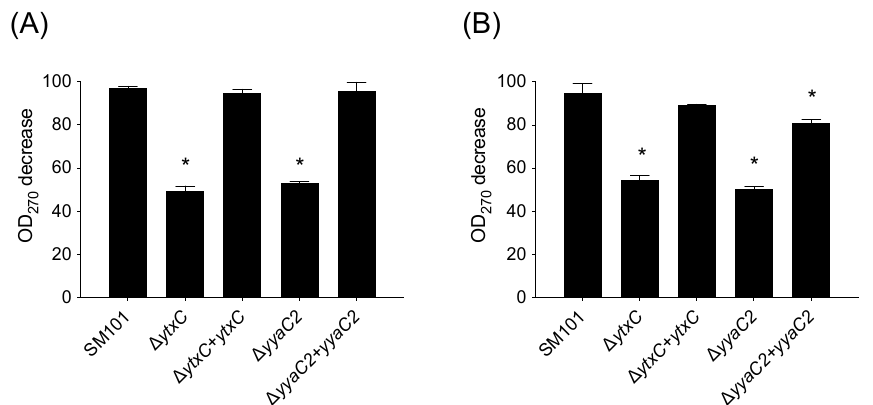
Figure 7. DPA release during germination of spores of C. perfringens mutant and complemented strains. Heat-activated spores of C. perfringens strain SM101 (wild-type), Δ ytxC mutant, Δ ytxC+ytxC ( Δ ytxC mutant complemented with wild-type ytxC ), Δ yyaC2 mutant, and Δ yyaC2+yyaC2 ( Δ yyaC2 mutant complemented with wild-type yyaC ), were incubated with ( A ) 100 mM KCl in 25 mM Tris- HCl (pH 7.0); and ( B ) L-cysteine in 25 mM Tris-HCl (pH 7.0) at 37 °C for 90 min and DPA release was monitored by measuring OD 270 as described in Material and Methods. The data represents the means of three replicates and error bars represent standard deviations. Statistical significance was determined by one-way ANOVA followed by Dunnett’s multiple comparison test. The asterisk (*) denotes the significant differences ( p < 0.05) in the values of each isolate compare to the value obtained from the wild-type strain.